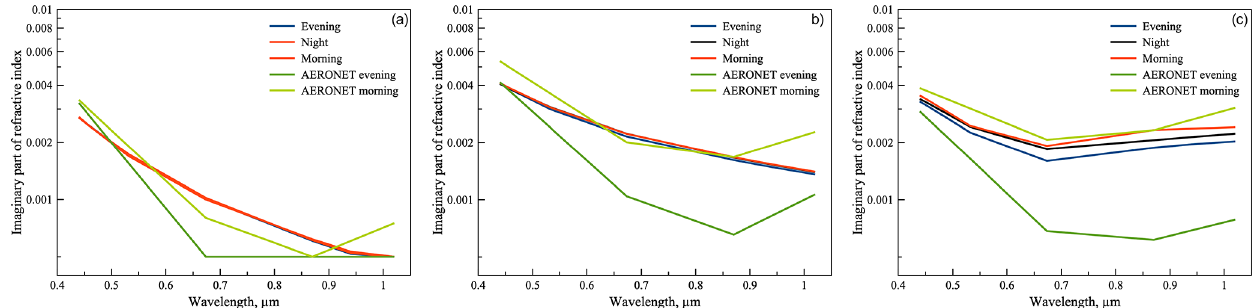
Figure 7. Imaginary parts of aerosol complex refractive indices retrieved during the COBALD radiosonde flight on 5 August 2015 (a) , 11 August 2015 (b) and 12 August 2016 (c) . Values retrieved before and after the radiosonde flight with the use of combined Sun-photometer and MPL data are shown in blue and red, and those retrieved by AERONET are in dark and light green,